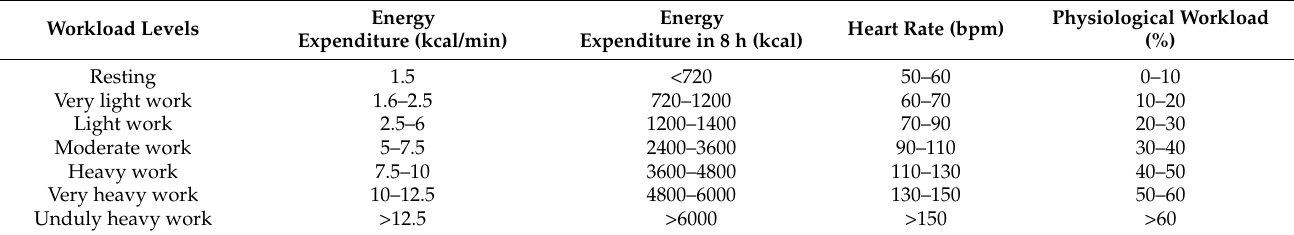
Table 2. Physical work classification according to Çaliskan and Çaglar